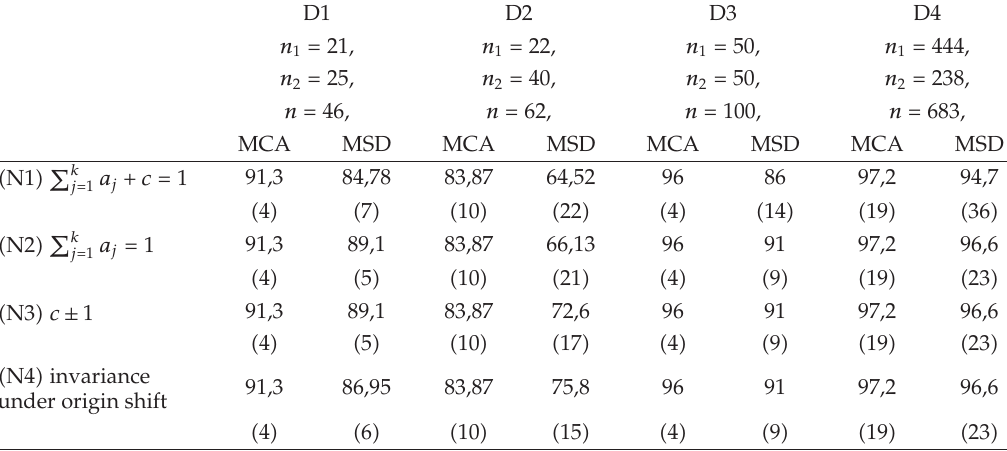
Table 2: The correct classification rates of the MCA and MSD models (cid:2) in percentage (cid:3) . D1 D2